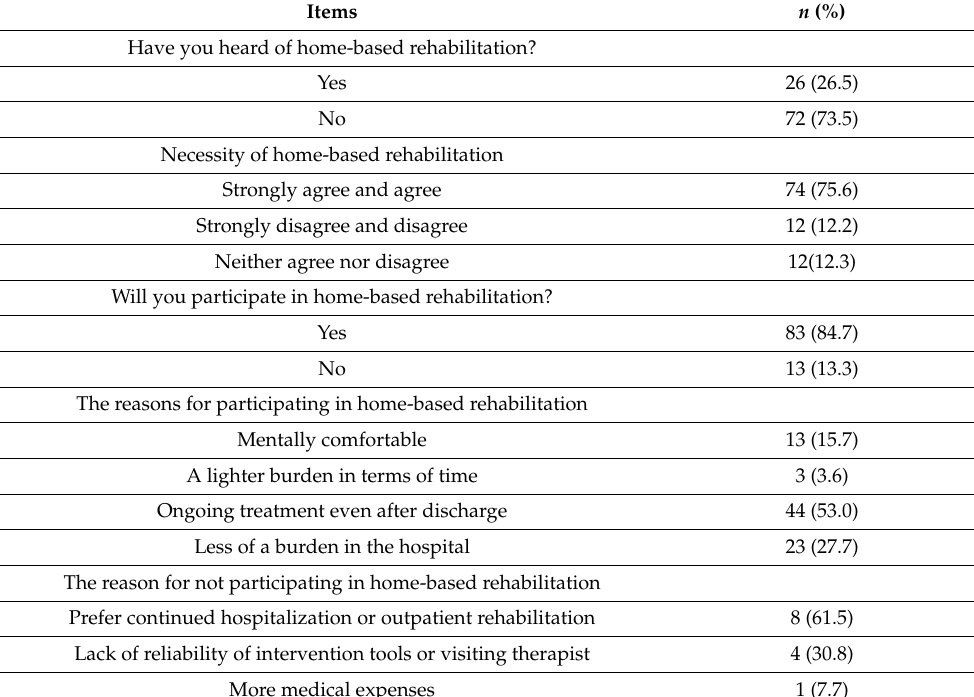
Table 2. Patients’ awareness and needs of home-based rehabilitation programs ( n =